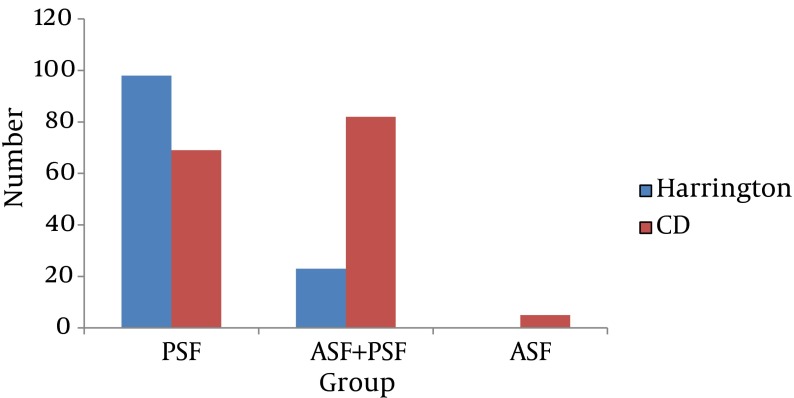
The Mean (ASF, PSF and ASF+ PSF) in the Two GroupsAbbreviations: ASF, anterior spinal fusion; PSF, posterior spinal fusion